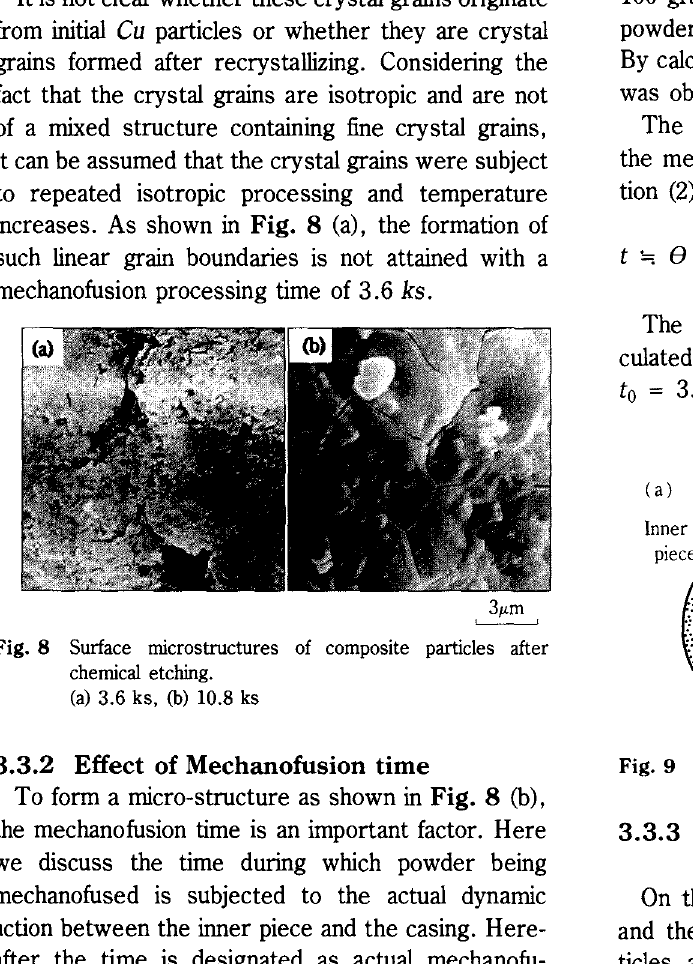
Fig. 9 Schematic diagrams of the mechanofusion